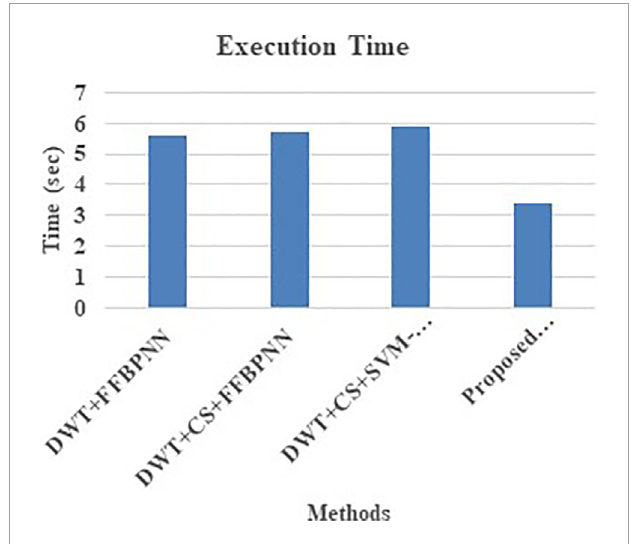
FIGURE 6 Comparative analysis of Execution